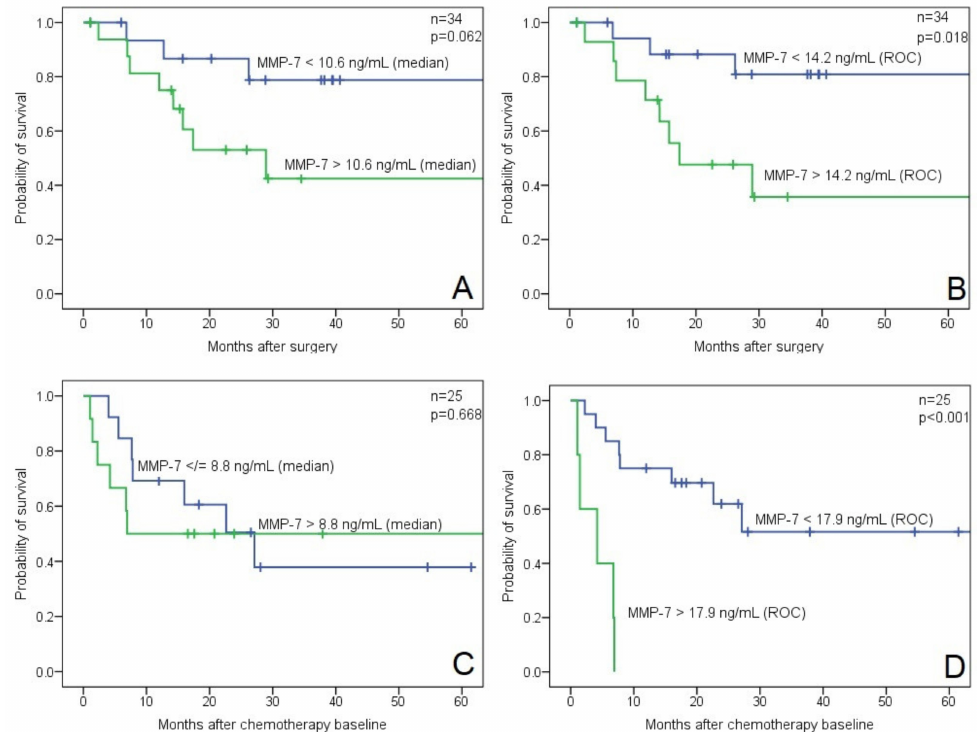
Figure 2. Kaplan–Meier OS analyses with log-rank tests ( A ) for the RNU cohort with a median value, ( B ) for the RNU cohort with an ROC cut-off, ( C ) for CTX cohort with a median value, and ( D ) for the CTX cohort with an ROC cut-off (blue line—low MMP-7 cc., green line—high MMP-7 cc.; cut-off values are shown on each